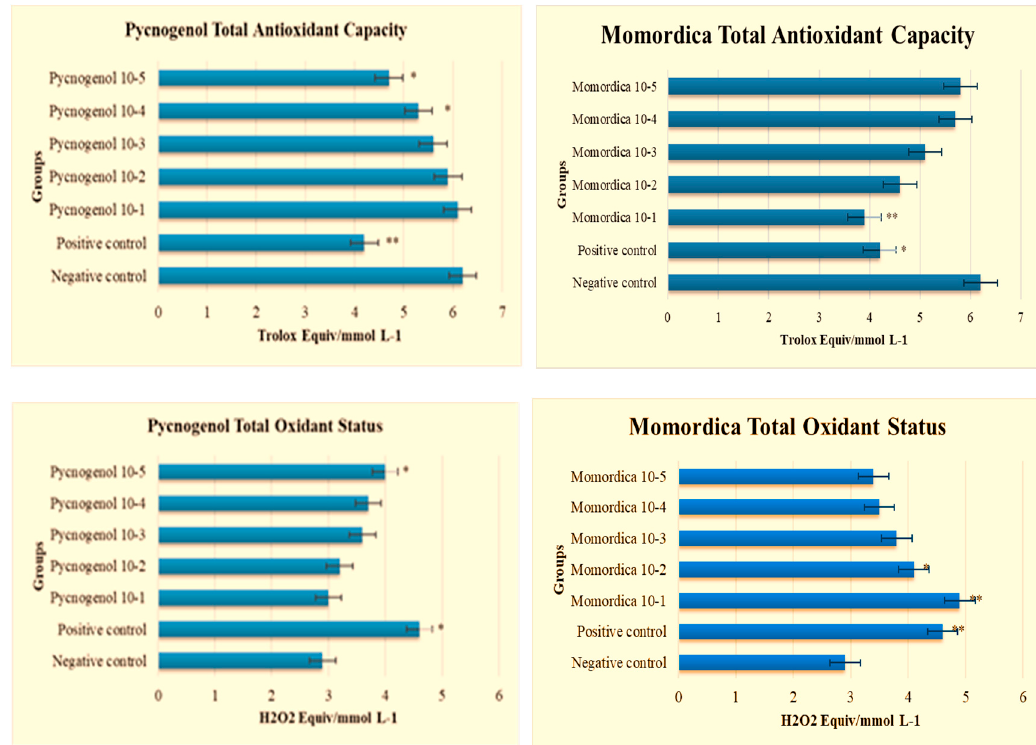
Figure 2. TAC and TOS of pycnogenol and momordica protective effect on induced imazamox toxicity effect on fibroblast cells ( n = 6/group) were shown. * Significant differences at p < 0.05 compared to control group; ** Significant differences at the p < 0.001 compared to control